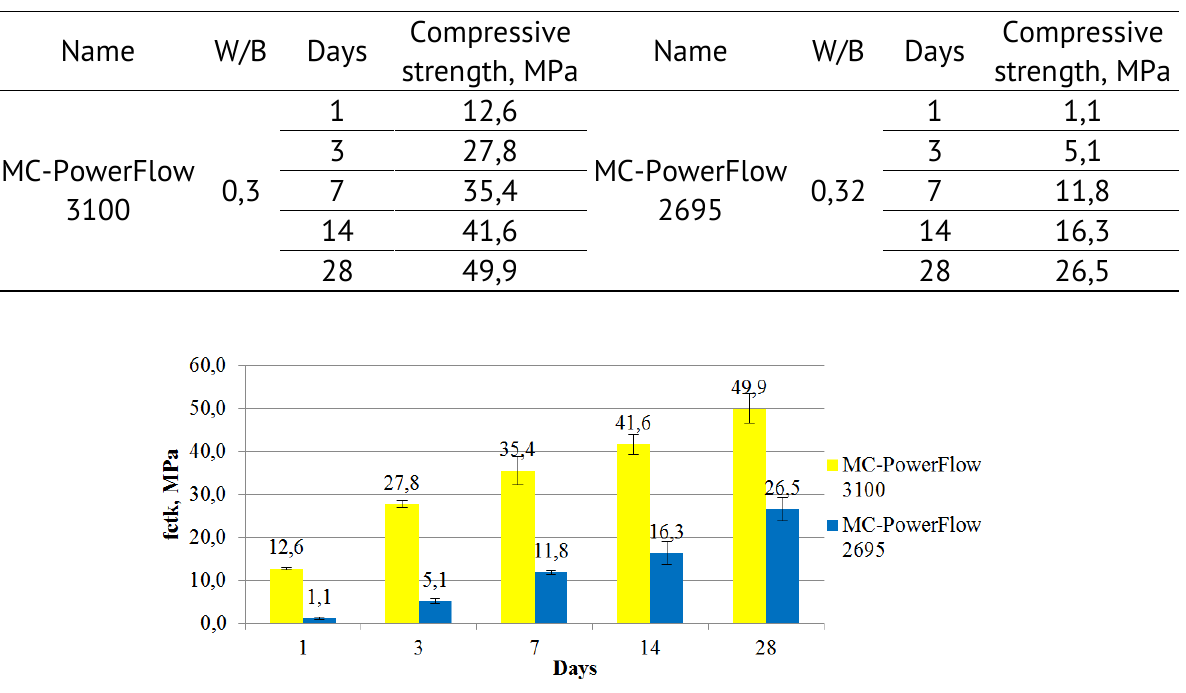
Figure: 1. Comparison of the compressive strength of concrete versus its age, using additives of plasticizers, when storing samples in a normal hardening